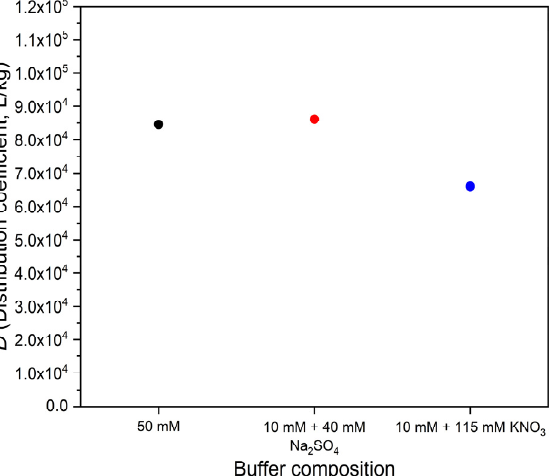
Figure 6. Ionic strength effect on the distribution coefficient of ketoprofen adsorption on OASIS ® HLB sorbent, from three phosphate buffer solutions of pH 8.0 and approximately equal ionic